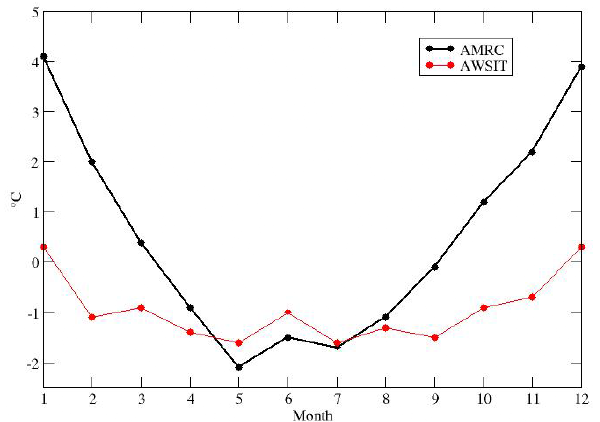
Figure 7. Annually averaged temperature over the period 2010– 2019. Coldest temperatures occur at the lowest model